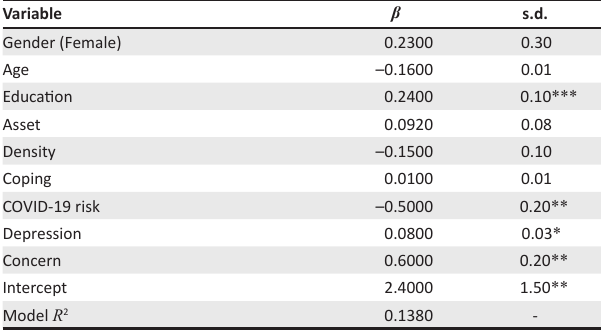
TABLE 5: Predictors of coronavirus disease 2019 knowledge.